Question: According to this chart, does the measure grow or shrink?
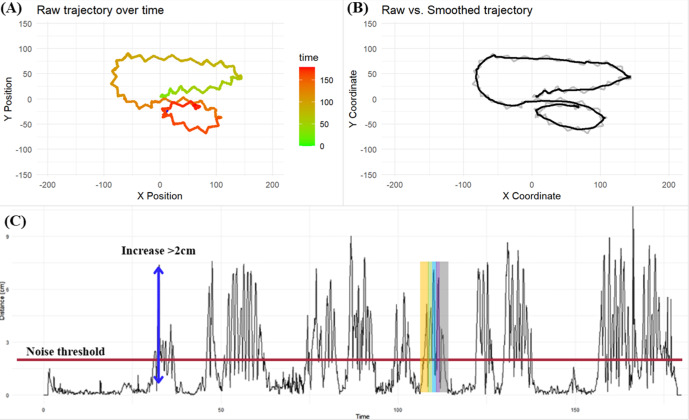
Answer: increasing